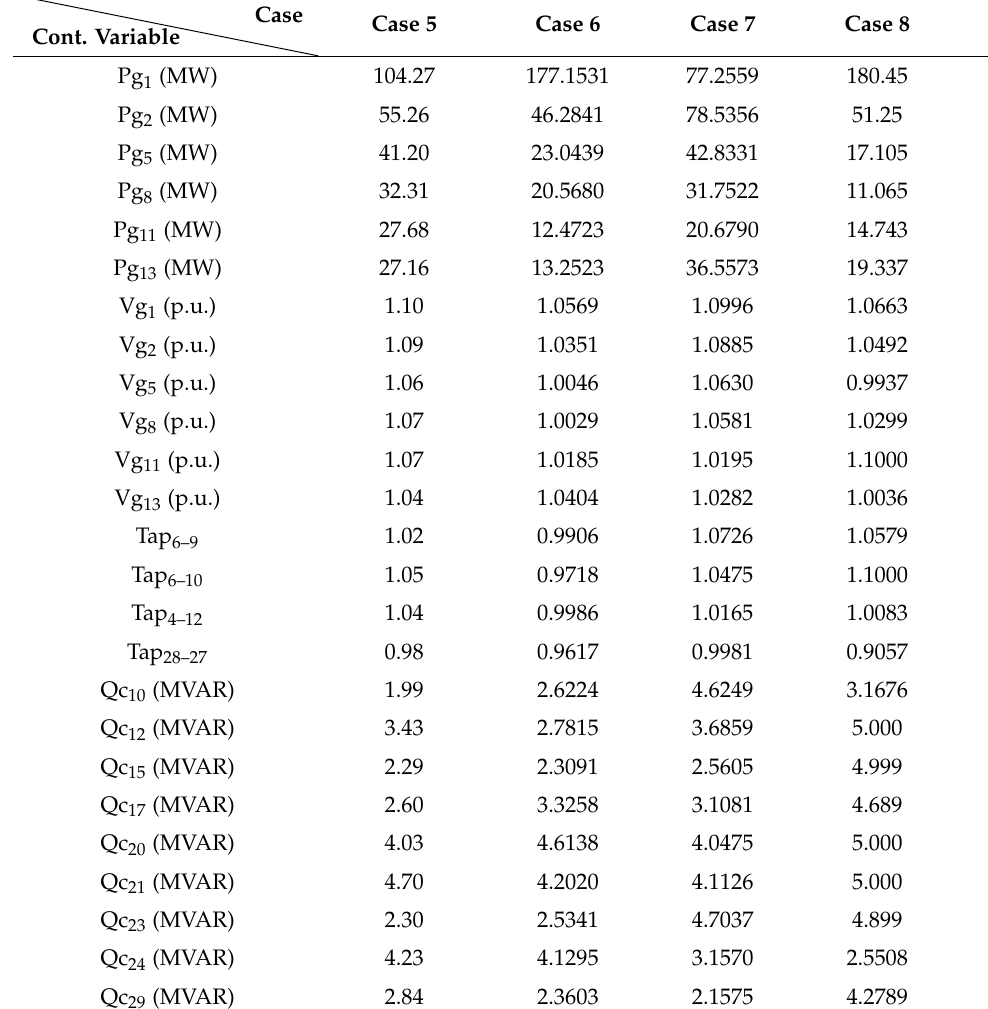
Table 7. Multi-objective OPF optimizations